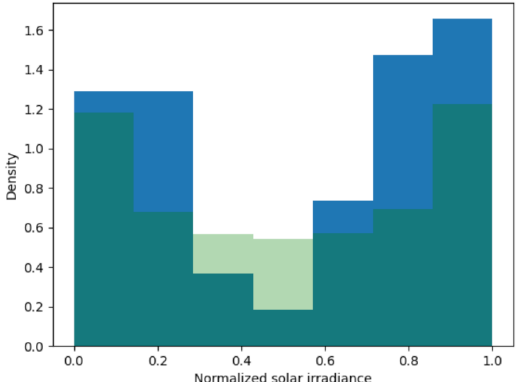
Figure 11. Empirical distribution (blue bars) and beta distribution fitting solar irradiance data of 13:00 of all days of January 2018 and 2019 (excluding anomalous data) using seven regions (green bars overlaid in transparency).